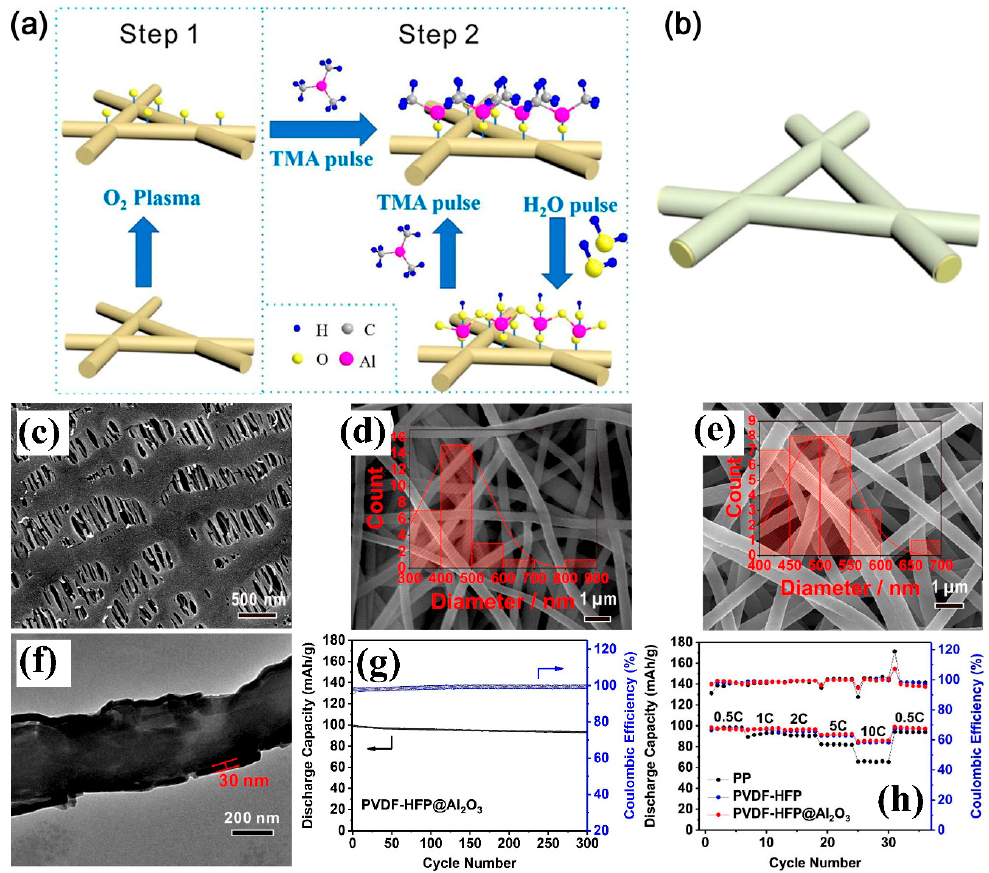
Figure 8. Schematic diagram depicted ( a ) the principle and the fabrication steps and ( b ) the final structure of ALD Al 2 O 3 core shell nonwoven separator. Top view of ( c ) PP separator, (d) PVDF-HFP fibrous membrane and ( e ) PVDF-HFP@ Al 2 O 3 . ( f ) TEM image of the PVDF-HFP@Al 2 O 3 fibrous membrane. ( g ) long cycling battery performance assembled with PVDF-HFP@Al 2 O 3 separator ( h ) discharge capacities of different separators at different C rates [126], with copyright permission from Elsevier.